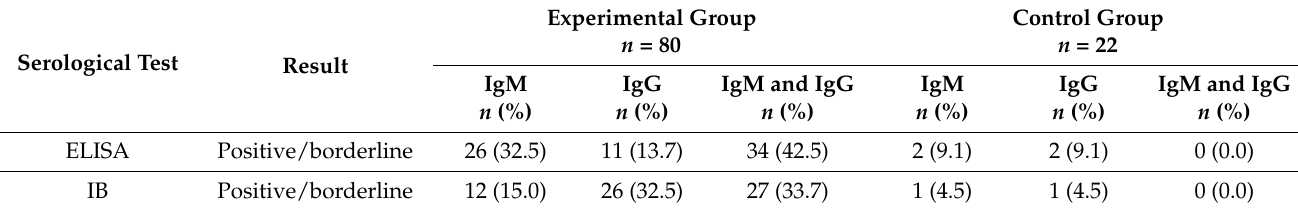
Table 1. Comparison of seropositive test results from enzyme-linked immunosorbent (ELISA) and immunoblot (IB) assays for IgM and/or IgG in Lyme disease patients (experimental group) and in healthy individuals (control group).